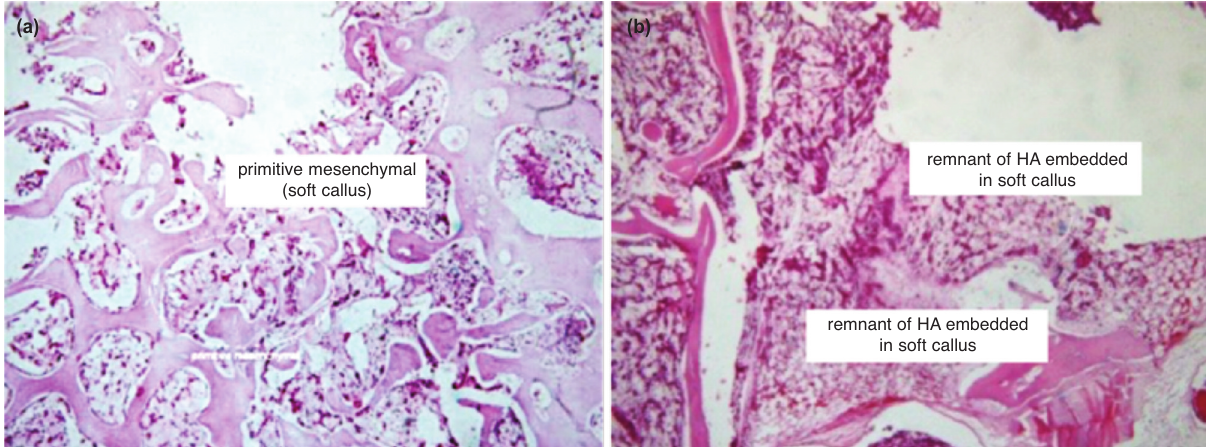
Histology features of group O1 (HA: PMMA ratio 1:1); (a) The space was partially filled with callus formation (20X, HE). (b) The Fig. 2: callus embedded in the remnant of HA material (20X, HE).